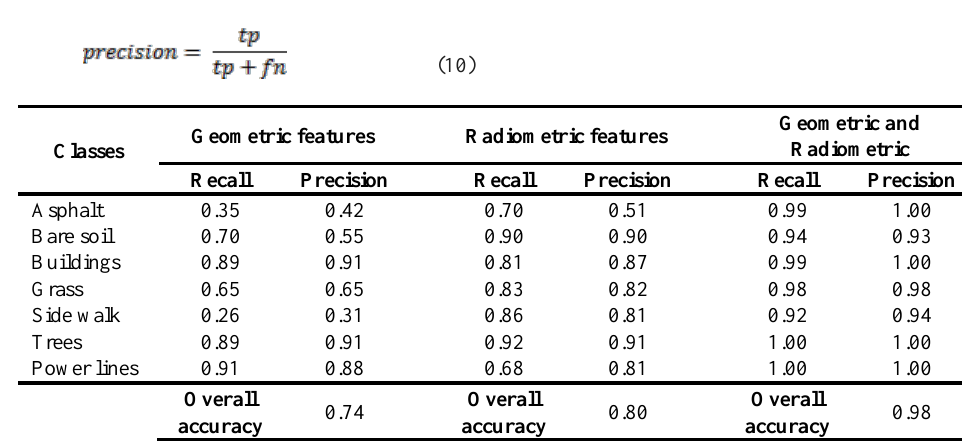
Table 3. Classification accuracy evaluation.